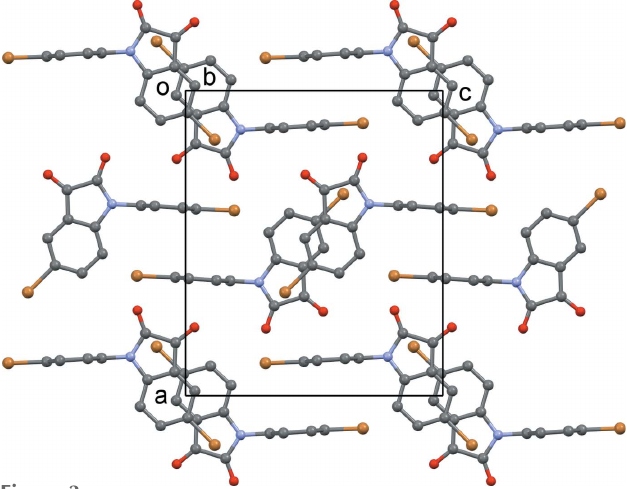
Figure 3 Crystal packing viewed along the b axis.